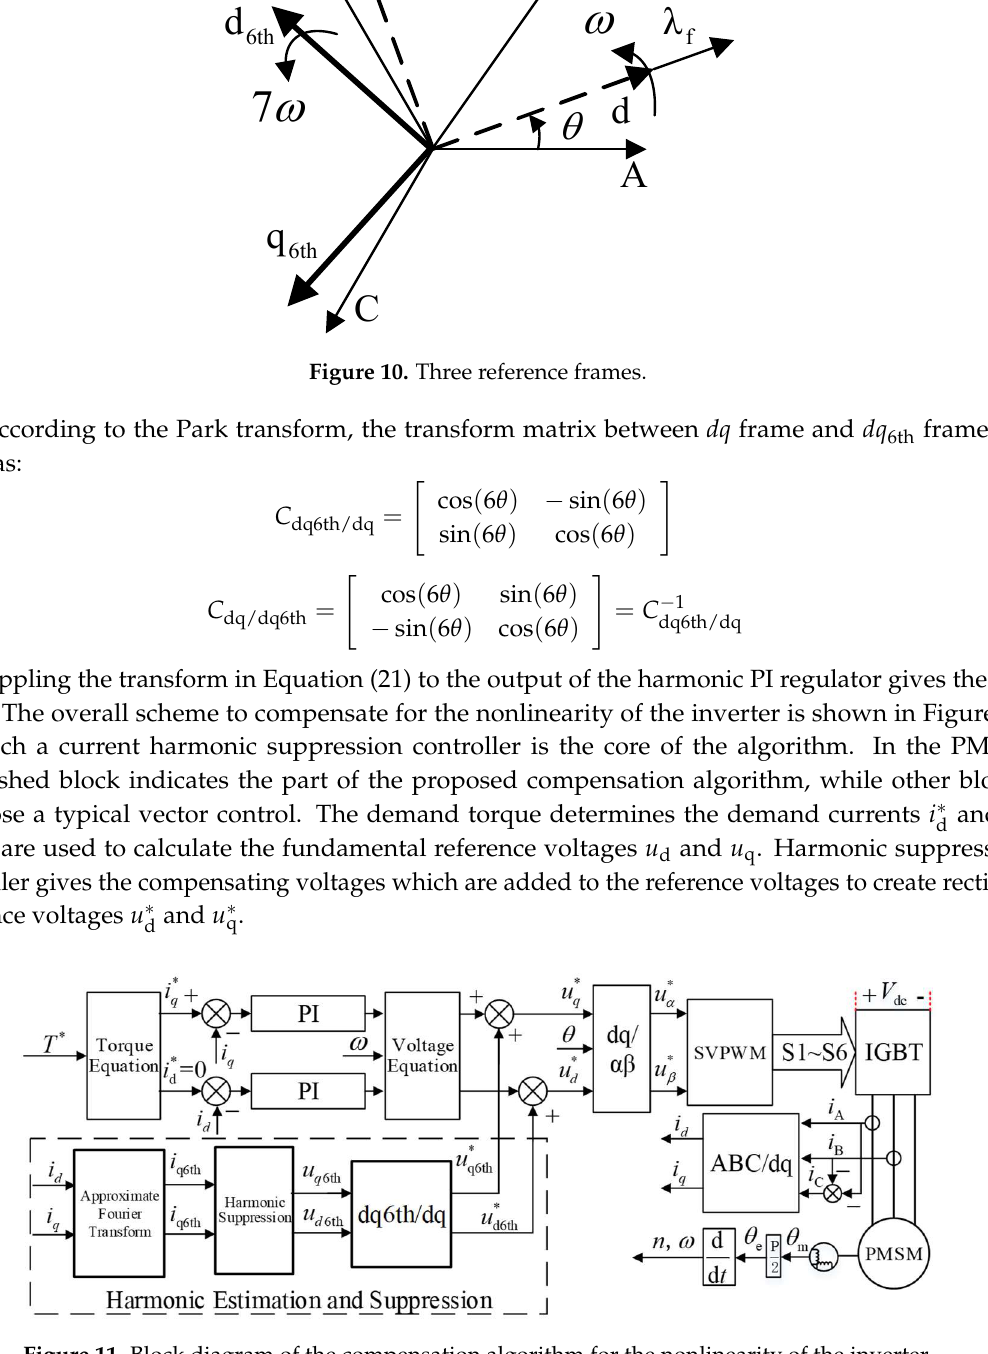
Table 1. Specification of the permanent magnet synchronous motor (PMSM).